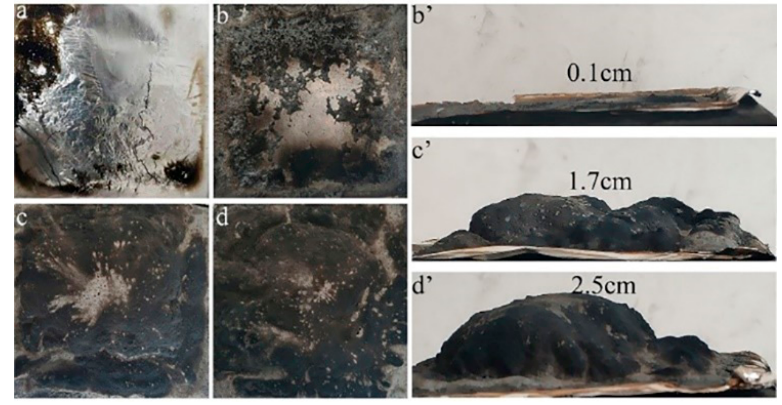
Figure 8. Digital photographs of residues of pure PP ( a ), PP/25%APP ( b , b’ ), PP/22.5%MAPP ( c , c’ ), and PP/25%MAPP ( d , d’ ) samples after CCT.